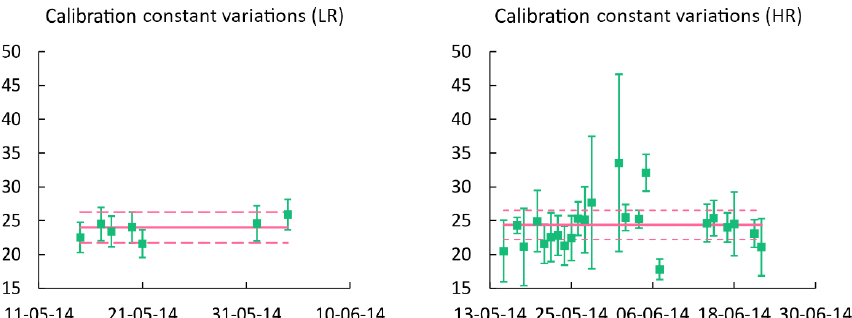
Figure 1. Variations of the water vapor calibration constant calculated based on low-resolution (LR) and high-resolution (HR) radiosound- ings. Green bars: calibration constant variations, red solid line: mean calibration constant, dashed lines: maximum and minimum calibration constants.